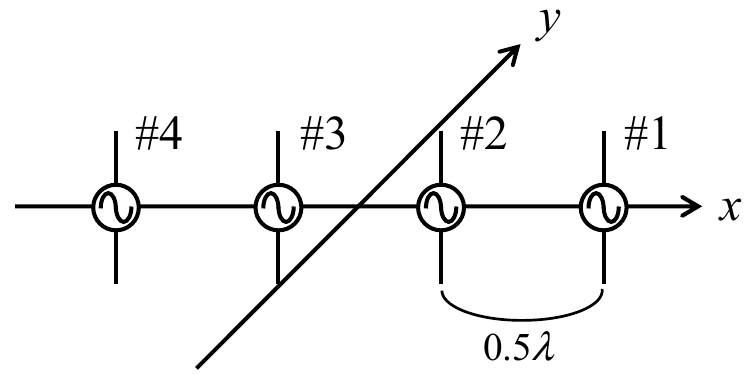
Figure 14. Configuration of the four-element MIMO terminal. Table 2. Measurement and analytical conditions.